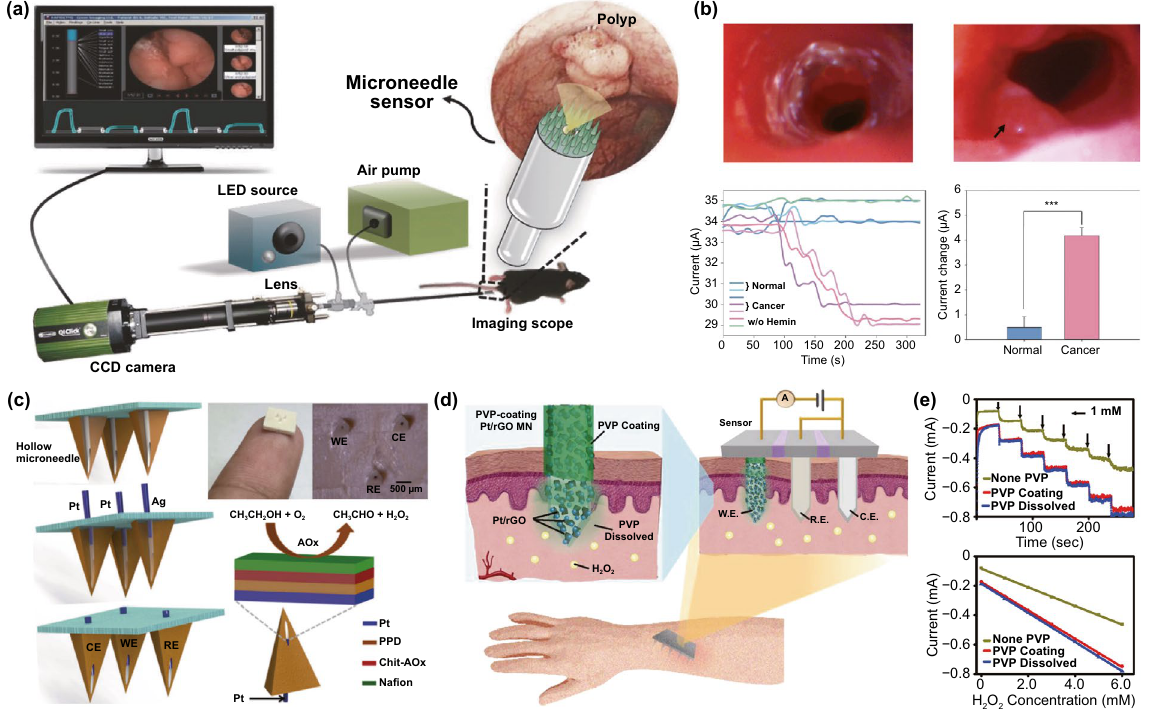
Fig. 15 Microneedles‑based biosensors for essential physiological biomarkers detection. a‑b Microneedle sensor and endomicroscopy device integrated dual‑diagnostic system for real‑time cancer‑specific NO signal detection [247]. a Schematics of applying the system for in vivo imag‑ ing and sensing on colorectal cancer model mice. b Real‑time in vivo endomicroscopic imaging of normal and polyp regions (black arrow indicates) in mouse colons, and corresponding detected NO signals. c Illustrations and images of functionized wire electrodes and hollow microneedles assembled biosensor for monitoring alcohol in ISF [248]. d, e Microneedle electrochemical platform with rGO/Pt nanoparticles immobilized and dissolvable polymer coating developed for real‑time subcutaneous ROS monitoring [249]. d Schematics of the microneedle ROS sensor and the surface structure of WE. e Amperometric responses of PVP‑coated sensor after inserting into the pigskin and withdraw, referring to the non‑PVP‑coated sensor. Reproduced with permission from Refs. [247–249], copyright (2015) Wiley–VCH Publishing